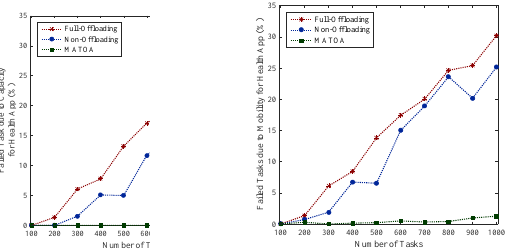
Figure 11. Healthcare Application performance without and with mobility